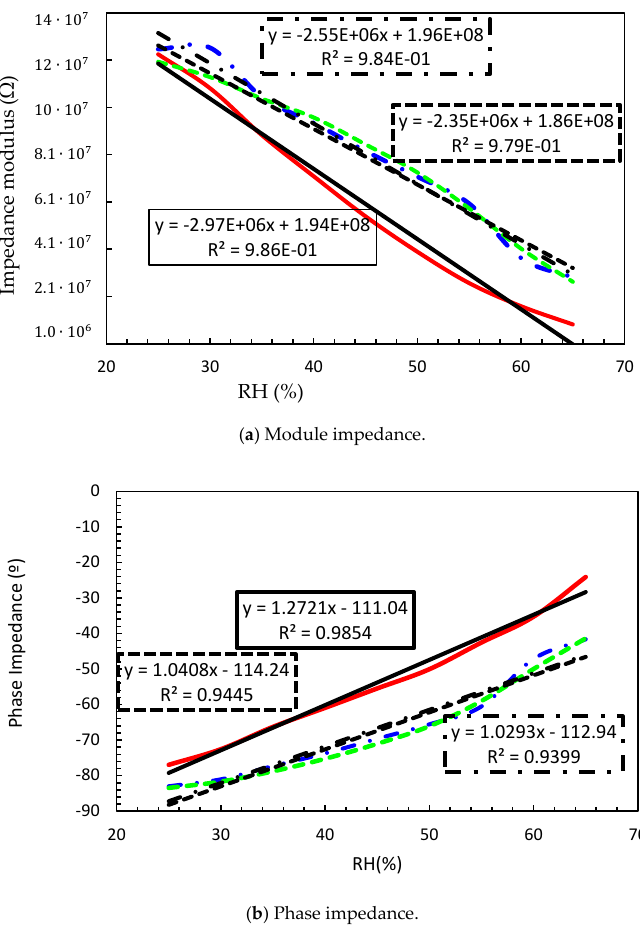
Figure 7. Effect of washing cycles on the impedance at 200Hz. Before washing (continues line), after one washing cycle (dot-dash line), and after two washing cycle (dash line). The linear regression for each case and the equations are also show.